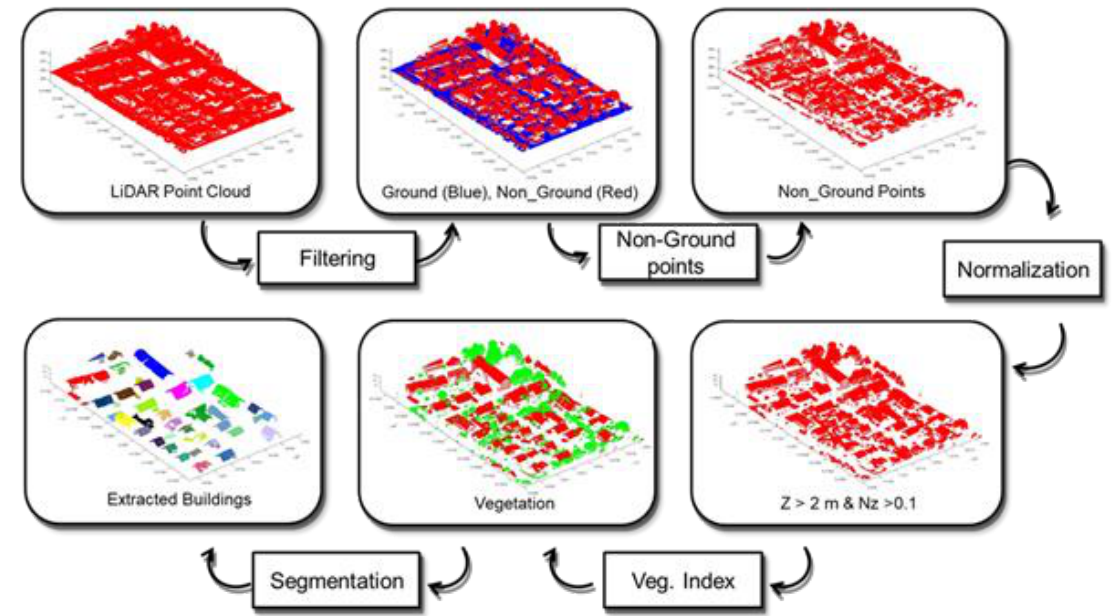
Figure 1. Flowchart of the proposed